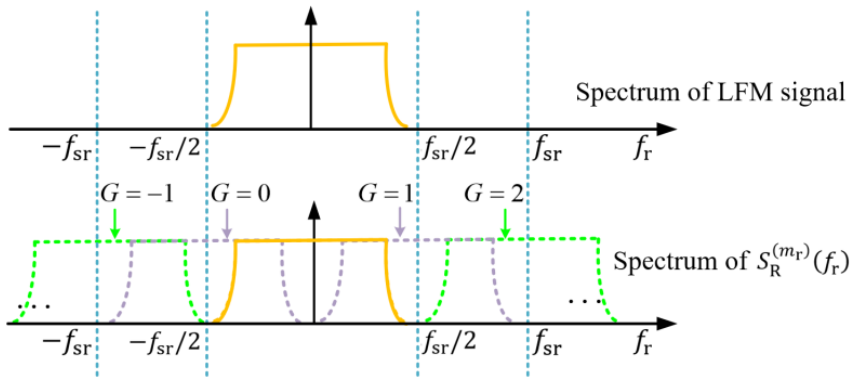
Figure 7. Schematic diagram of range echo component spectrum.